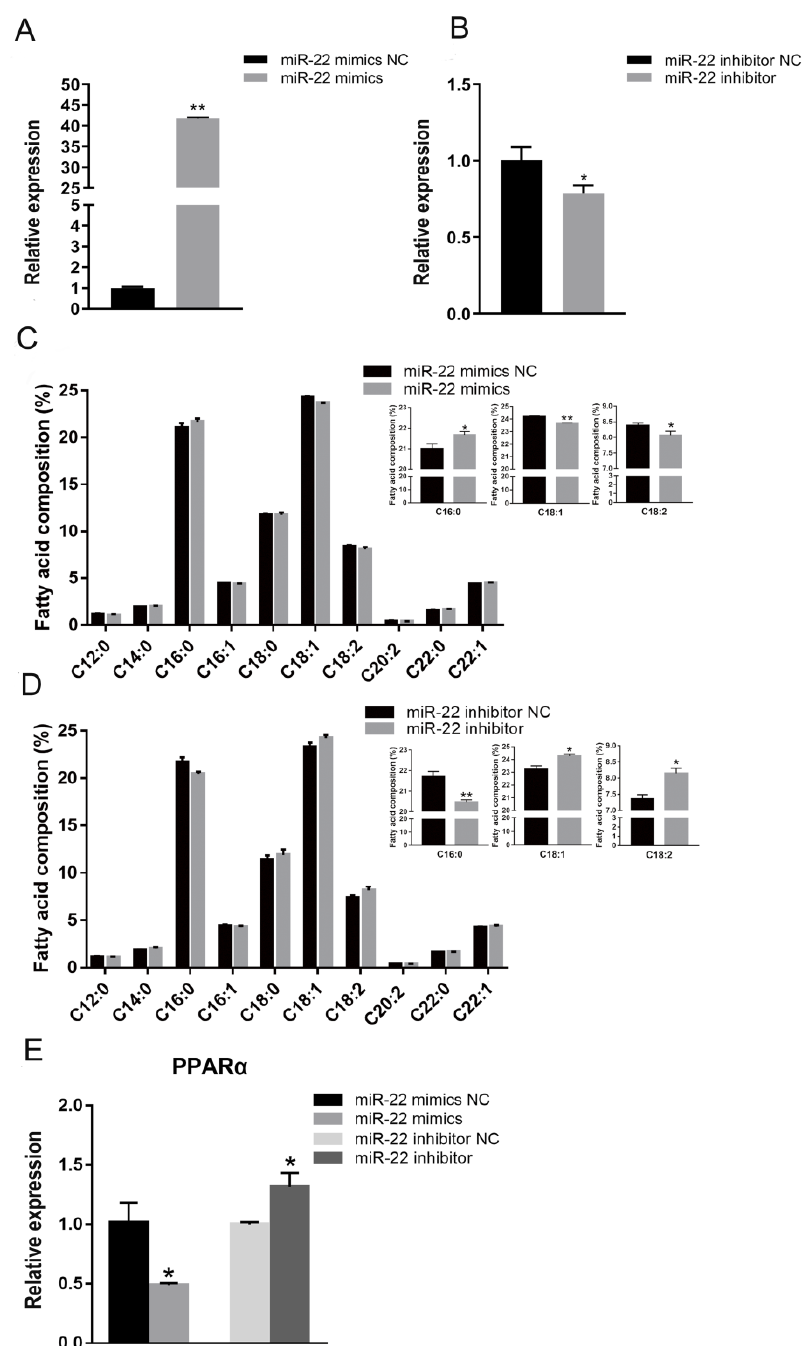
Figure 1. MiR-22 inhibits fatty acid elongation in C2C12 cells. ( A ) The expression of miR-22 was detected using qPCR in myotubes transfected with miR-22 mimics or negative control (NC). ( B ) miR-22 expression was detected in myotubes following transfection with miR-22 inhibitor or inhibitor NC. ( C ) Fatty acid composition was measured after C2C12 cells had been transfected with miR-22 mimics or NC for 24 h. The contents of C16:0, C18:1, and C18:2 were determined. ( D ) Fatty acid composition was measured after C2C12 cells had been transfected with miR-22 inhibitor or inhibitor NC for 24 h. The contents of C16:0, C18:1, and C18:2 were determined. ( E ) Expression of PPAR α at 24 h after transfection. * p < 0.05, ** p < 0.01. Data represent mean ± SEM from at least three independent experiments.